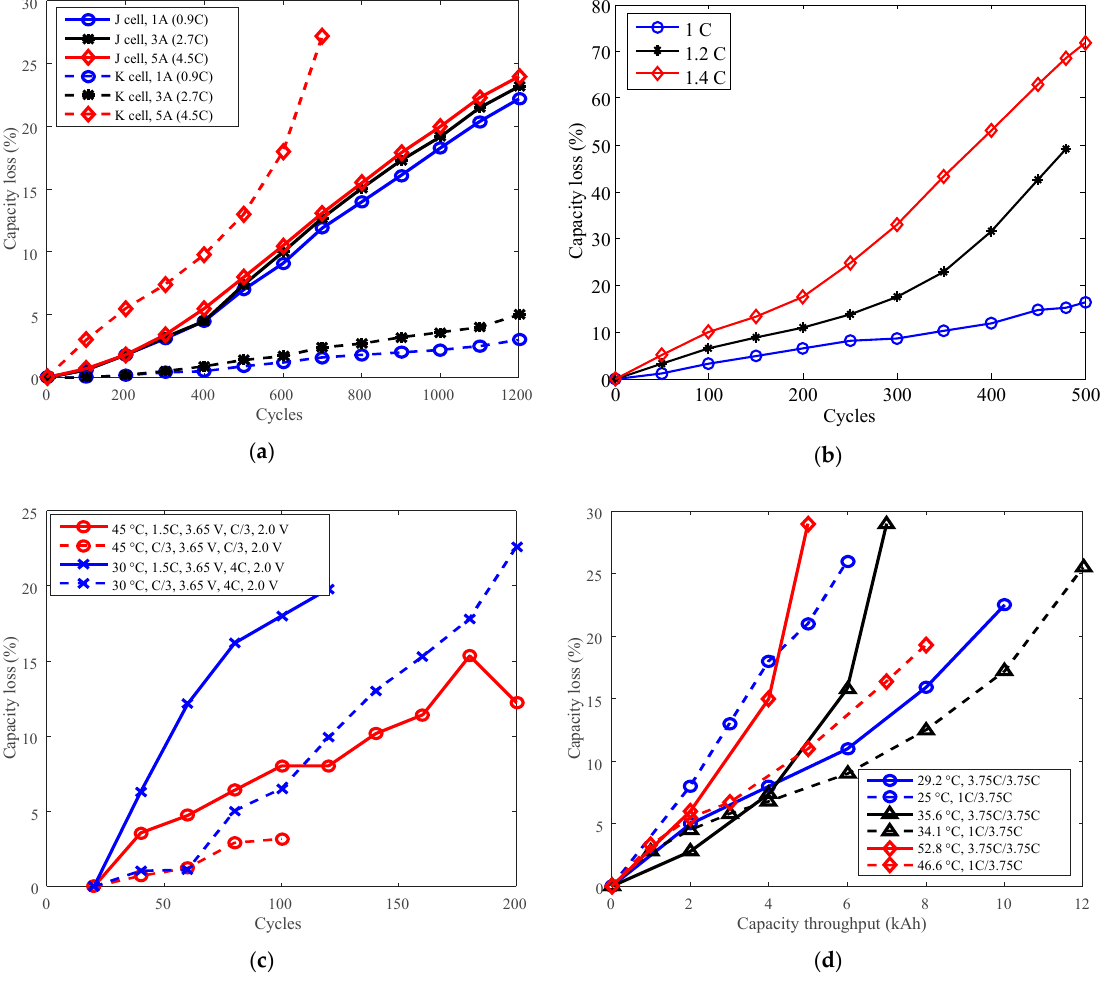
Figure 9. Battery cycle degradation data under various charge C-rates. (a) “J cell, 1 A (0.9C)” refers to battery J charged CC 1 A (0.9C) to 4.1 V, CV to 100 mA (C/11), and finally discharged CC 3 A (2.7C) to 2.5 V under temperature 25 °C. “K cell, 1 A (0.9C)” refers to battery K charged CC 1 A (0.9C) to 3.6 V, then CV to 100 mA; discharge: CC 3 A (2.7C) to 2.0 V under 25 °C. (b) Battery O charged CC to 4.2 V, CV hold 2.5 h, discharged CC 1C to 2.75 V under temperature 25 °C. (c) Battery G. (d) Battery P.